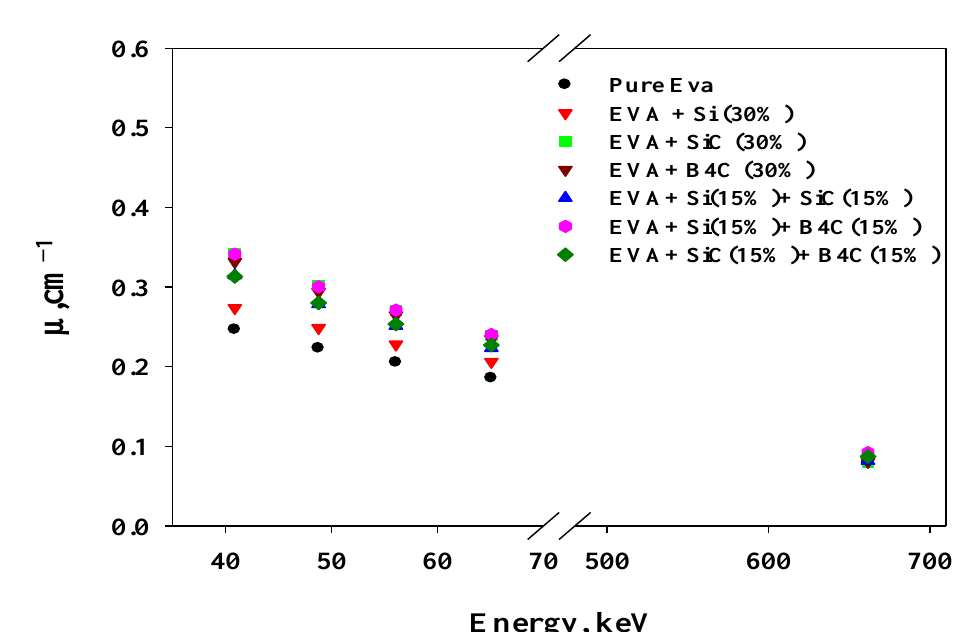
Figure 3. The experimentally measured µ values versus delivered energies in keV for the studied polymer composite samples. The error bars are smaller than the point size. Table 2. The measured and calculated µ m expressed in cm 2 g − 1 versus incident photon beam energy for the EVA based polymer composites coded A, B, C, D, E, F and